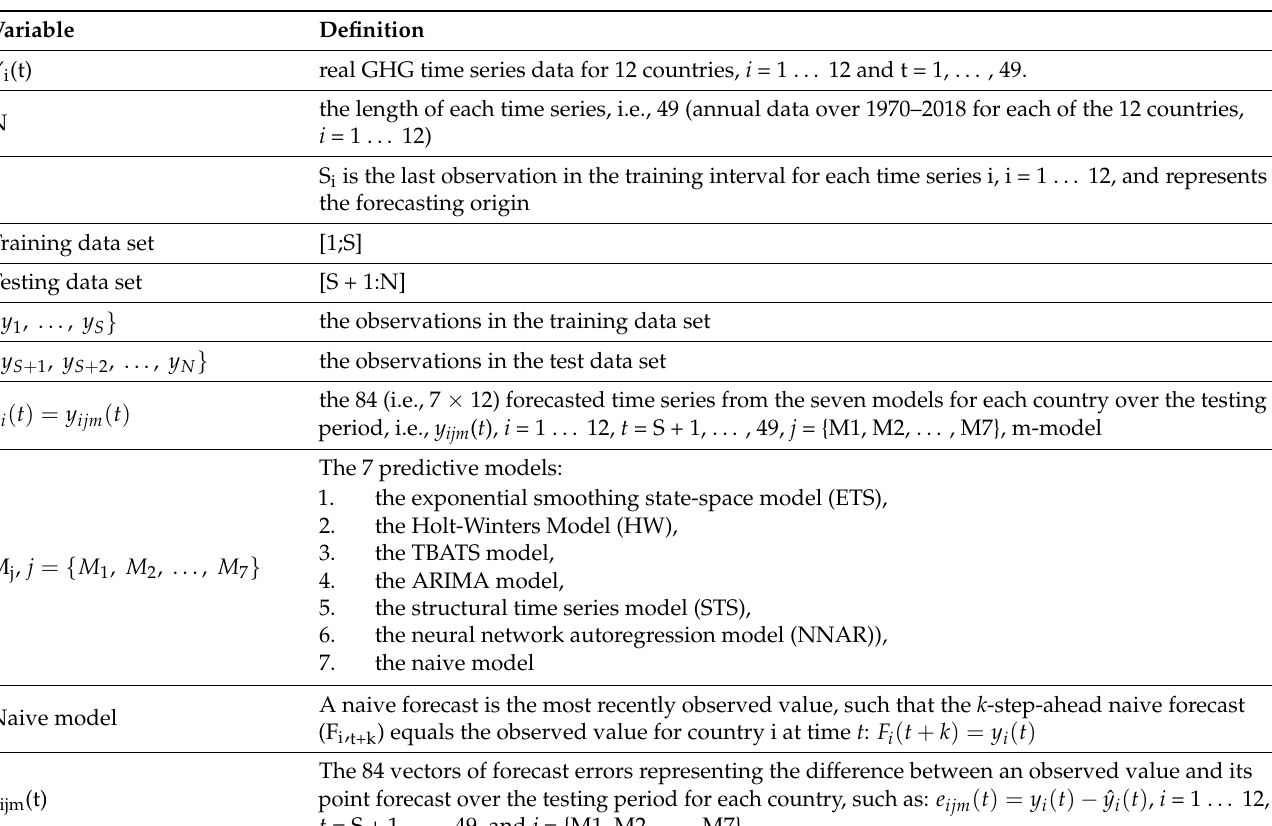
Table A1. Variables’ notations and